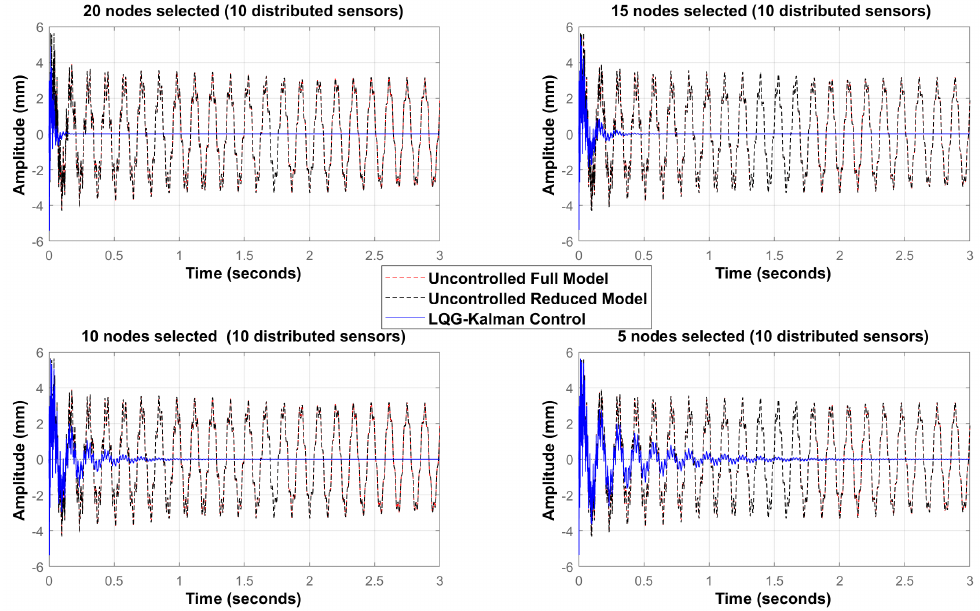
Figure 12. Impulse responses Corresponding to the LQG-Kalman control for different selections of dofs and 10 distributed sensors along the surface of the